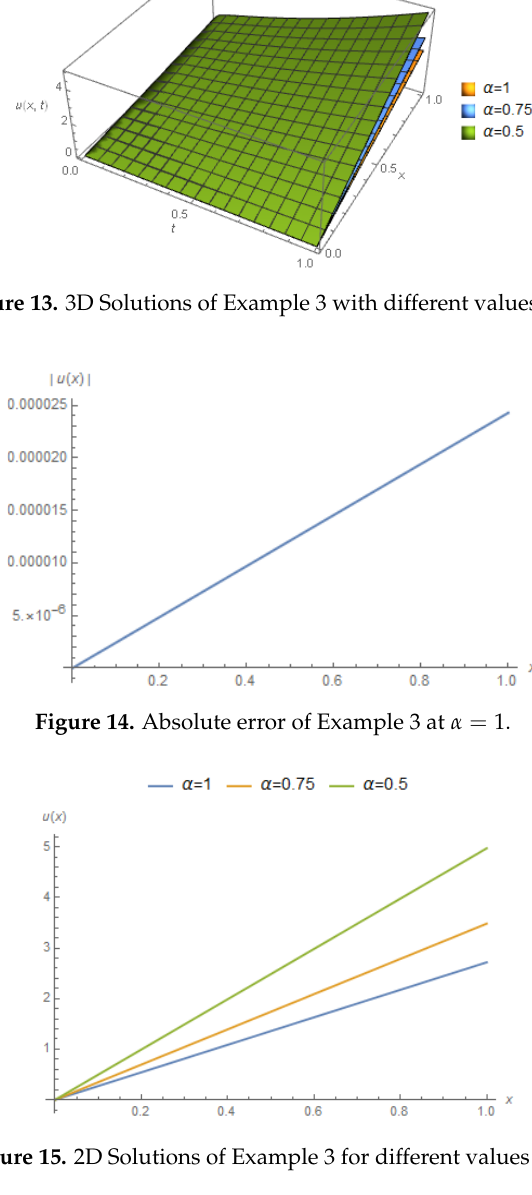
Figure 5:2D Solutions of example3 for Figure 15. 2D Solutions of Example 3 for different values of α di⁄erent values of (cid:11)